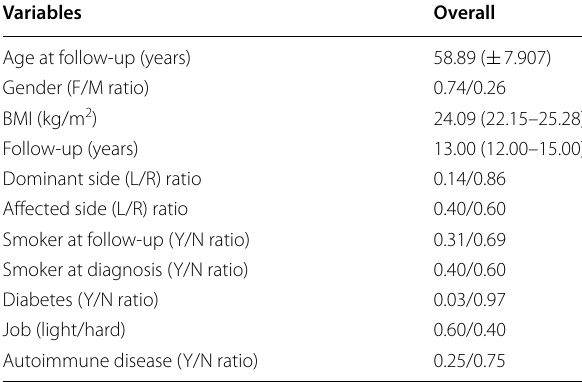
Data are reported as mean ( SD), median (Q1–Q3), or frequency/ratio ± BMI body mass index, F/M females/males, N No, L/R left/right, Q1 first quartile, Q3 third quartile, SD standard deviation, Y yes